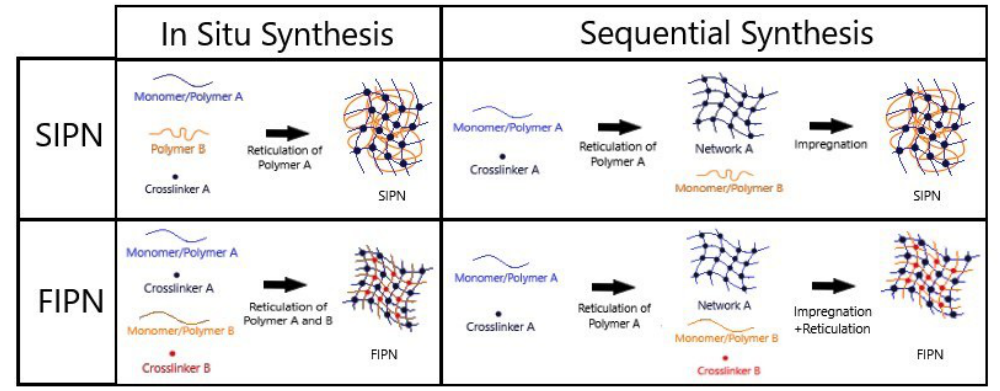
Figure 7. Classification of interpenetrating networks. SIPN: semi-interpenetrating networks ( upper row ); FIPN: full interpenetrating networks ( lower row ). In situ and sequential syntheses refer to the number of steps requiring for gel setting up.